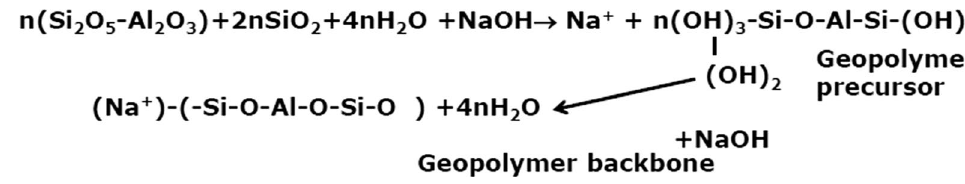
Fig. 26 Chemical reaction during geopolymerization of